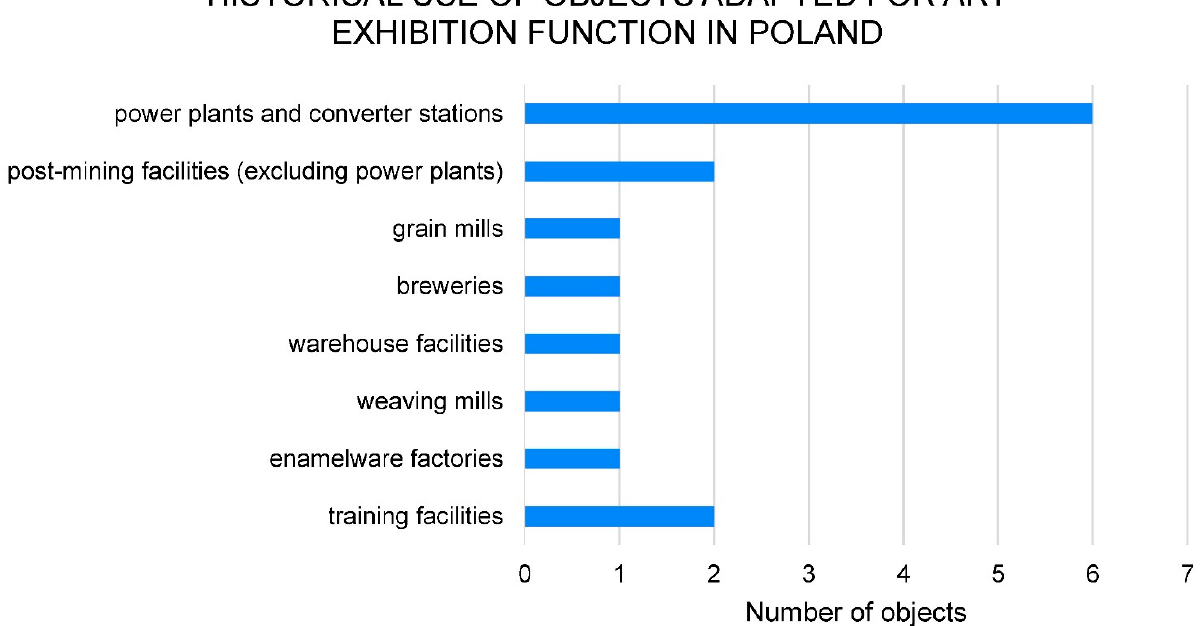
Figure 2. Historical use of objects adapted for art exhibition in Poland, authors’ work.